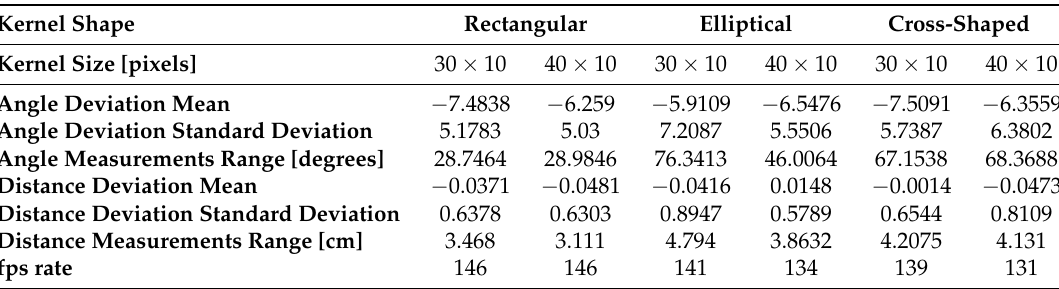
Table 6. Kernel shape and size variation results summary with a 160 × 120 pixels image resolution, and a linear speed of 0.21 m/s.